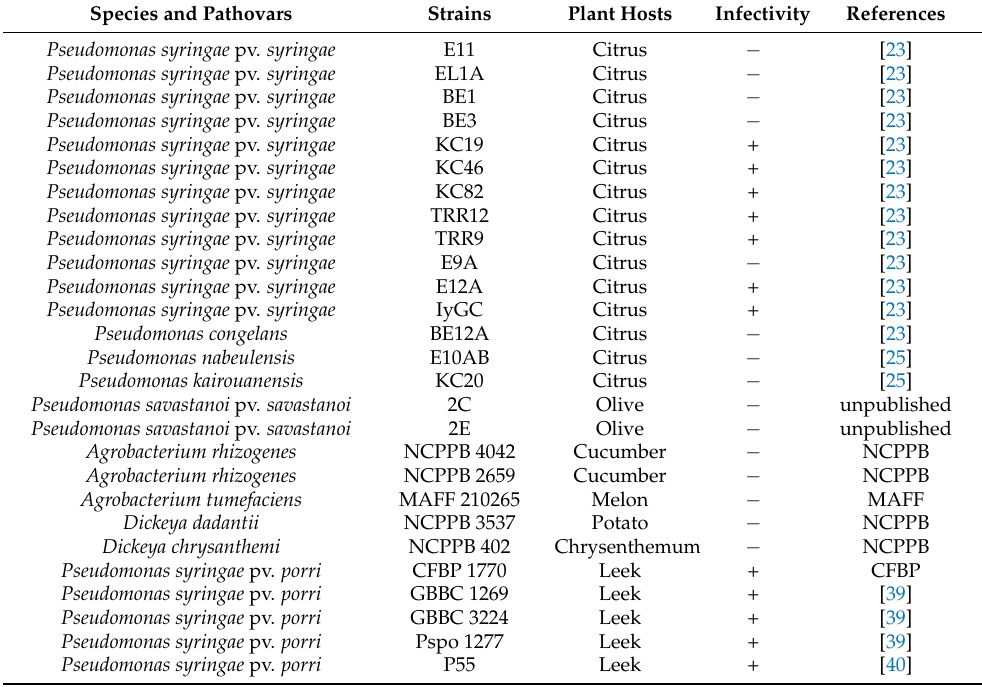
Table 1. Host Range of the SoKa phage on different host bacteria. A plus or minus sign respectively indicates susceptibility or resistance to phage infection. Culture collections: NCPPB—National Collection of Plant Pathogenic Bacteria, Harpenden, UK; MAFF—Ministry of Agriculture, Forestry, and Fisheries, Tsukuba, Ibaraki, Japan; CFBP—Collection Française des Bact é ries Phytopathog è